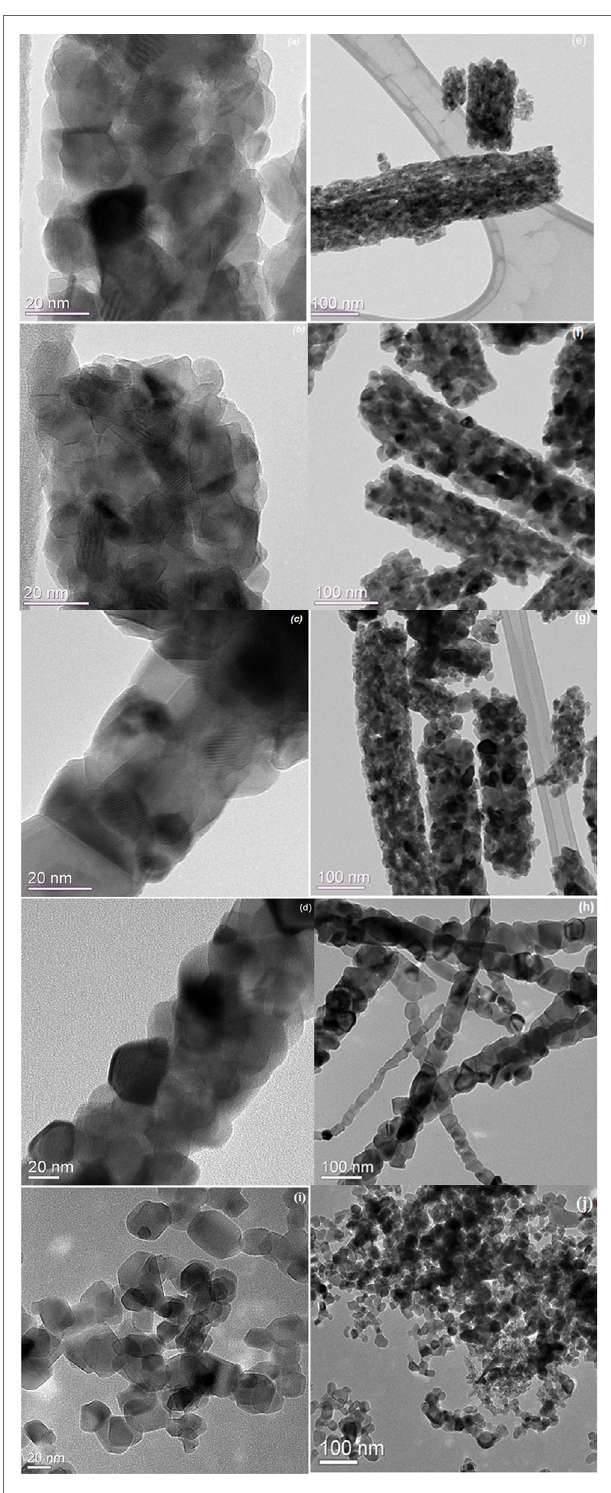
FigUre 6 | TeM images of pure TiO 2 nanofibers annealed (a) at 450°c, (B) at 500°c, (c) at 600°c and (D) at 700°c at high magnification and (e–h) are low magnifications, (i,J) P25 TiO 2